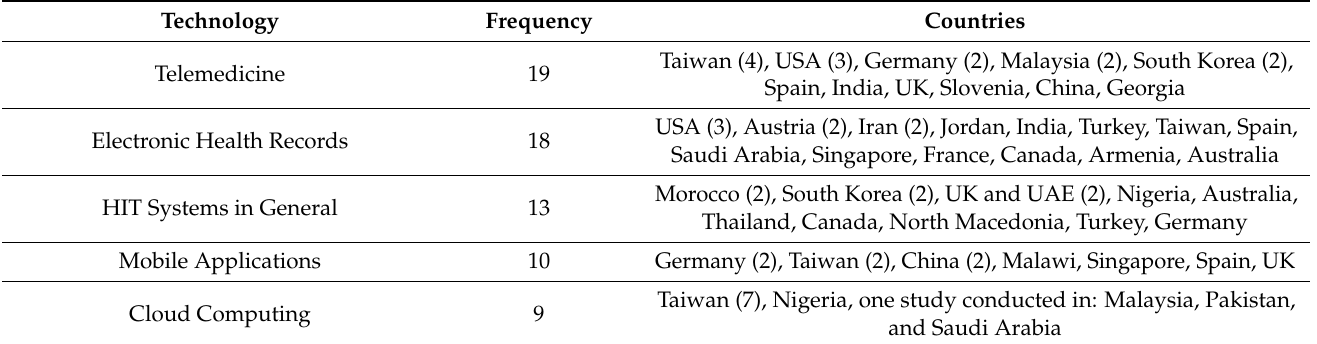
Figure 5. Distribution of studies in terms of technology type. Table 5. Technology types and directions of